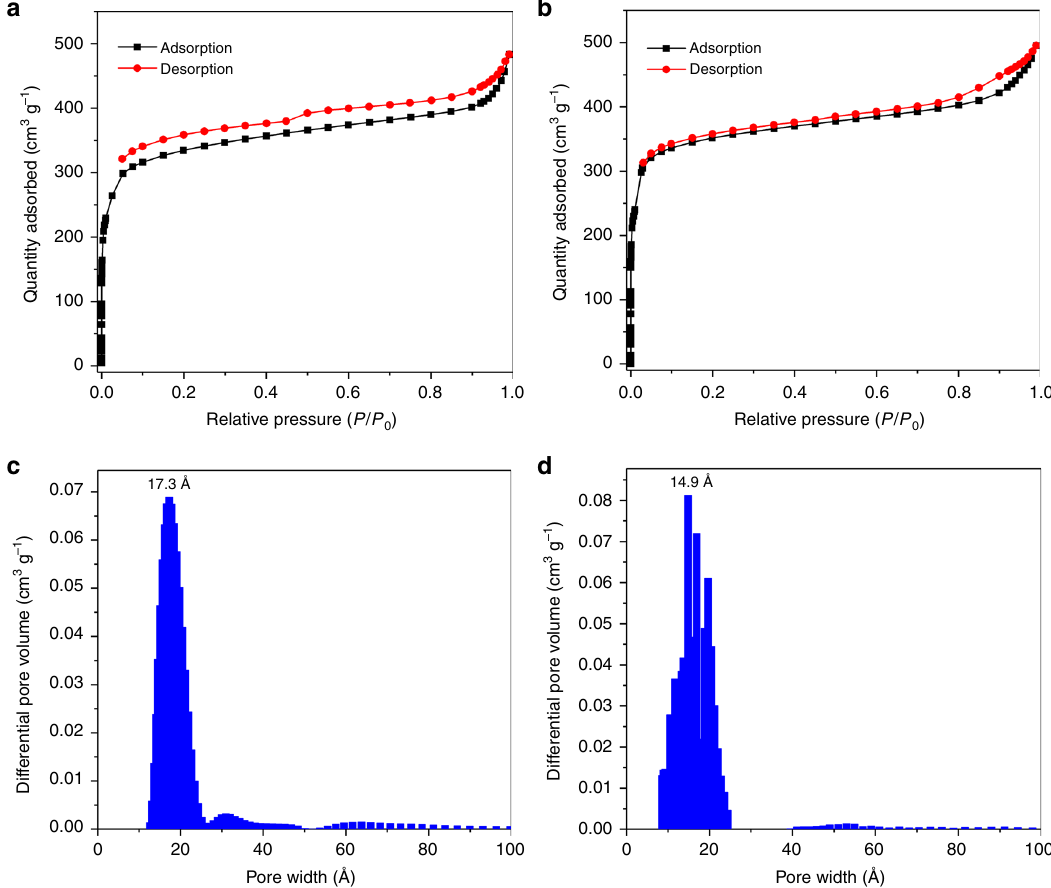
Fig. 5 Gas adsorption. N 2 adsorption isotherms (77 K) of a 3D-ETTA-TFPB and b 3D-ETTA-TFPA . Pore size distribution pro fi les of c 3D-ETTA-TFPB and d